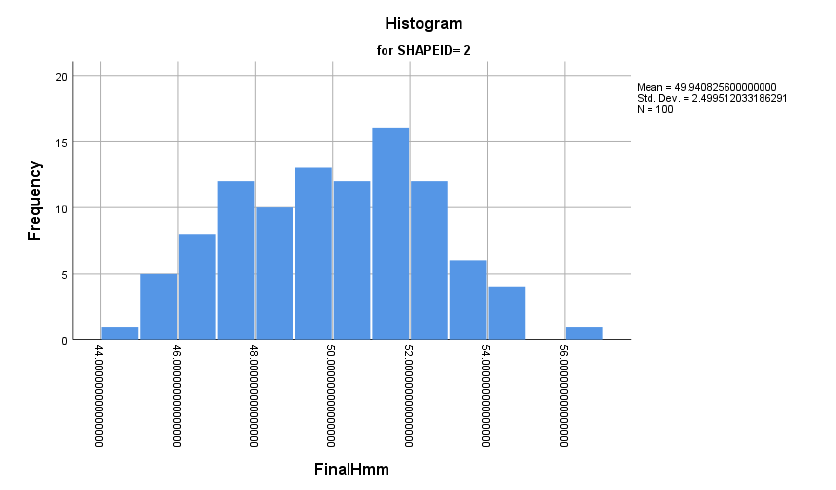
Figure A6. Grow height adjustment for 50 mm.